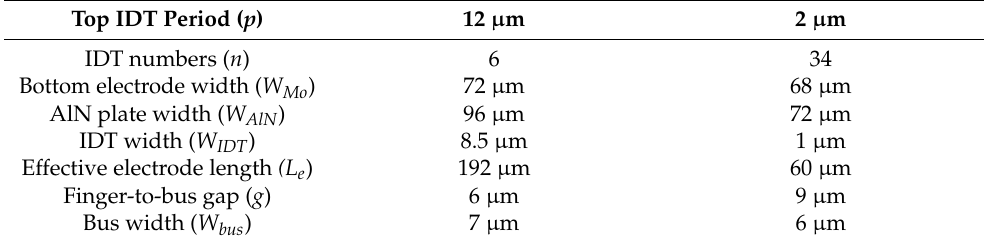
Table 1. Geometric dimensions of the designed AlN LWRs.